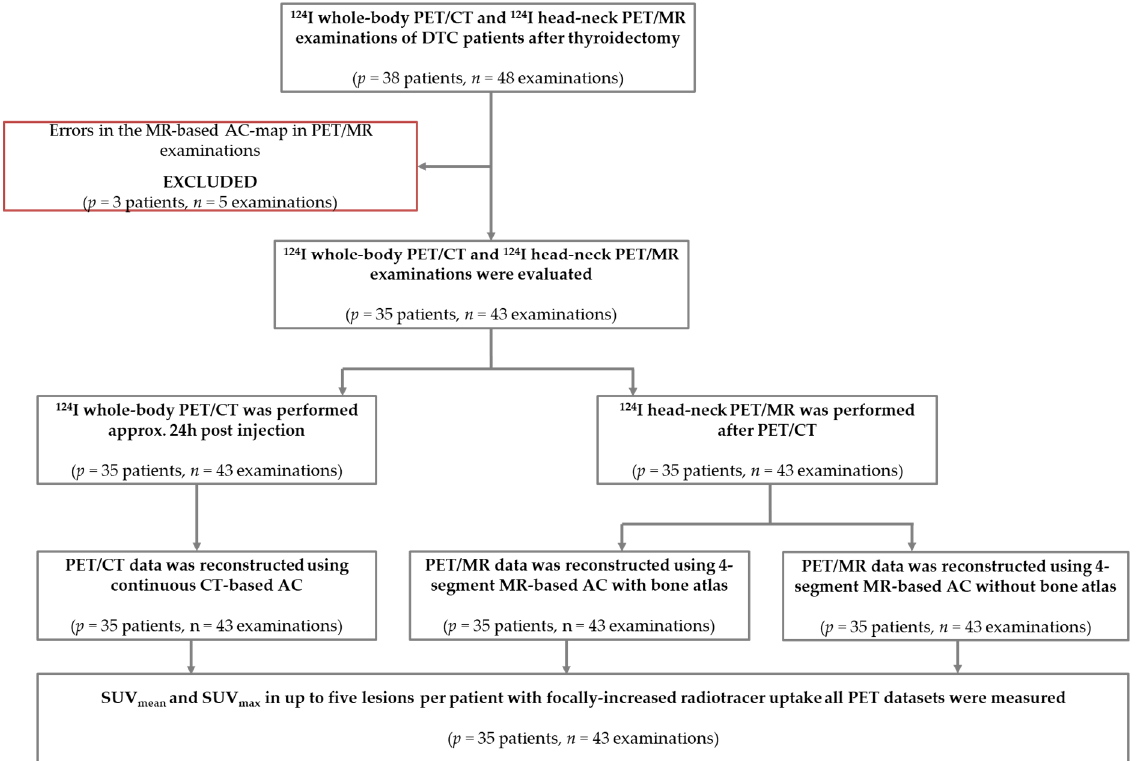
Figure 1. Flow chart of patients and PET/CT and PET/MR examinations analyzed in this study.